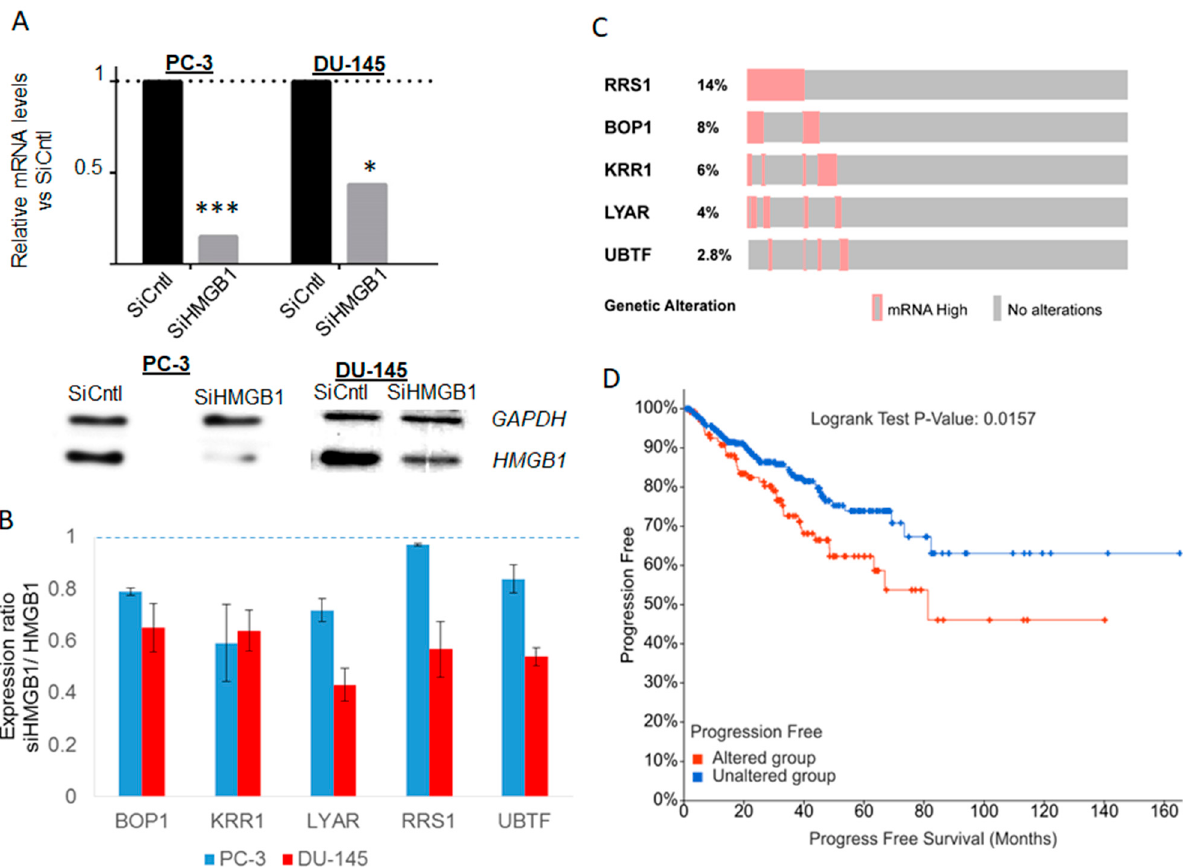
Figure 7. Effects of HMGB1 silencing on gene expression. ( A ) Verification of HMGB1 silencing by qPCR. (up) and Western blot (down); * p < 0.05, *** p < 0.001 ( B ) Effects of HMGB1 silencing on the expression of genes with regulatory functions in RNA processing and/or ribosome biogenesis. ( C ) Percentage of adenocarcinoma tumours with high expression (mean+2SD) of genes encoding regulators of rRNA synthesis and ribosome biogenesis. ( D ) Correlation of the expression of genes encoding these regulators (SRR1, BOP1, KRR1, LYAR, UBTF) and progression-free periods in prostate adenocarcinoma patients.